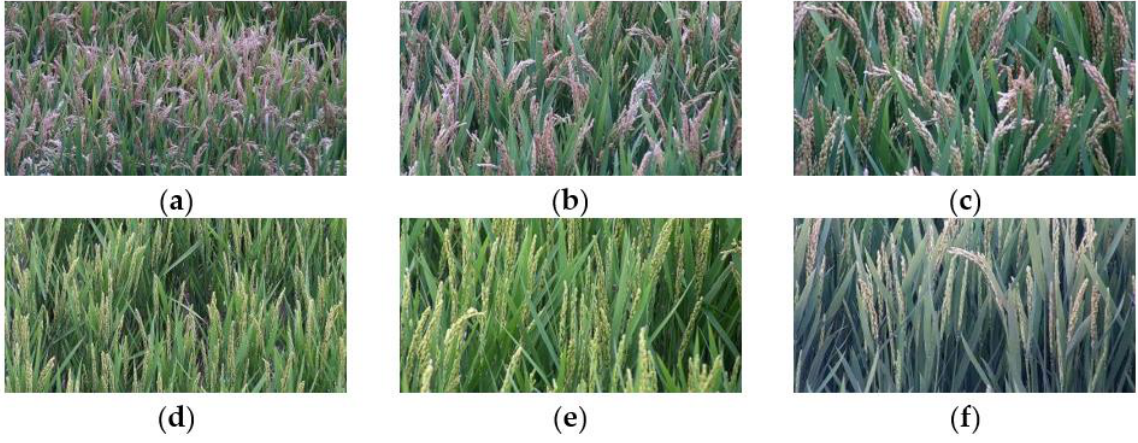
Figure 8. Example images from the test set: ( a ) No. 9; ( b ) No. 12; ( c ) No. 13; ( d ) No. 5; ( e ) No. 19; ( f ) No. 20.